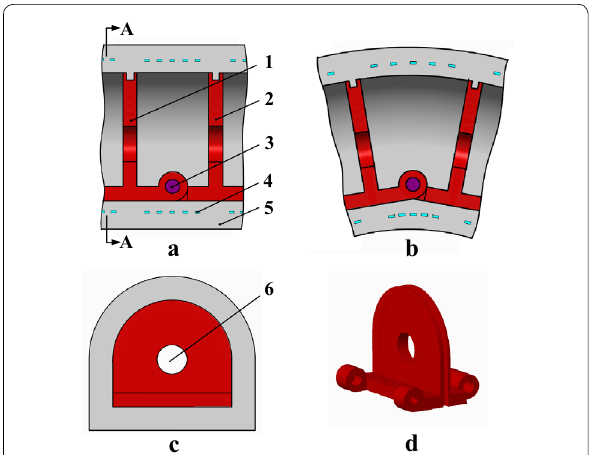
Figure 1 a Structure of a single finger joint; b Bending deformation of the finger joint during air charging; c A–A section view; d Three-dimensional view of an endoskeleton unit. 1. Endoskeleton unit 1; 2. Endoskeleton unit 2; 3. Hinge; 4. Fiber; 5. Silicon rubber; 6. Flow